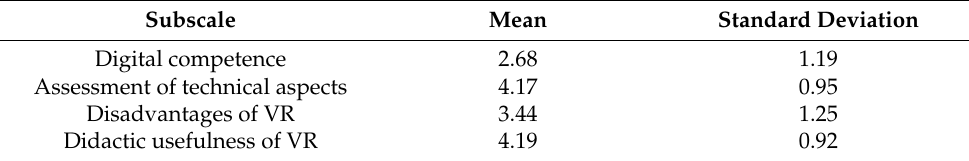
Table 7. Overall descriptive statistics (out of 5) of the answers to the survey. Subscale Mean Standard Deviation